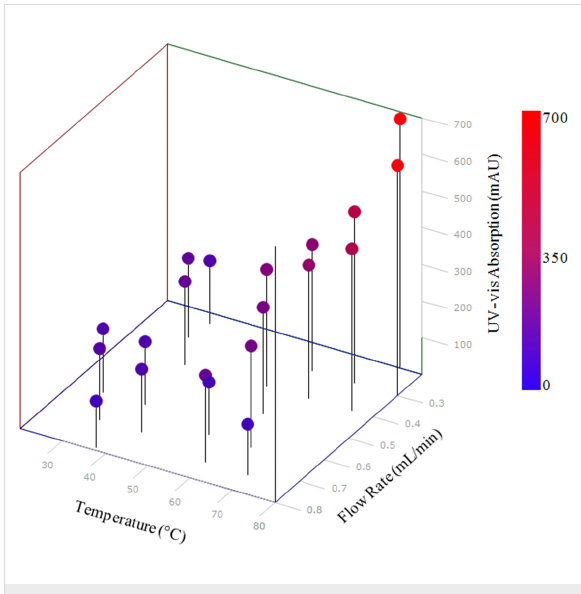
Figure 11: Optimisation plot for the SIMPLEX optimisation of semicar- bazone 2 . Optimum reaction conditions were found to be a flow rate of 0.2 mL/min and a temperature of 75